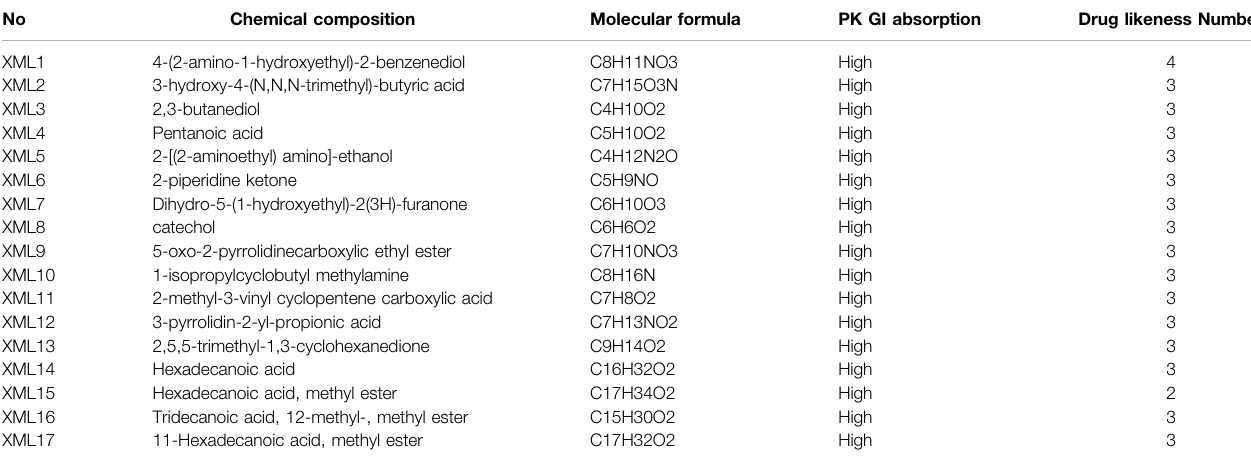
TABLE 2 | Basic information on the active compounds in XML